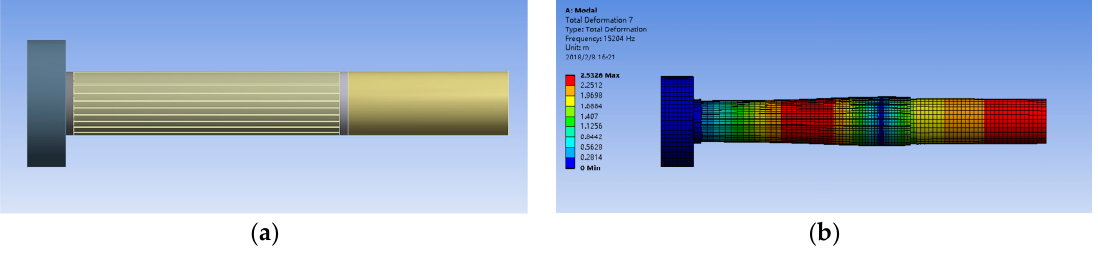
Figure 4. The modal diagrams in the range of 10 to 30 kHz. ( a ) model of compound vibrator; ( b ) The optimal vibratiom mode.